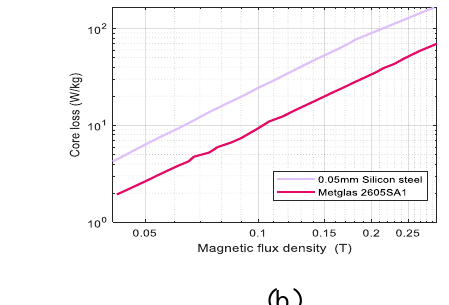
Table 4. DC-DC converter parameters for performance